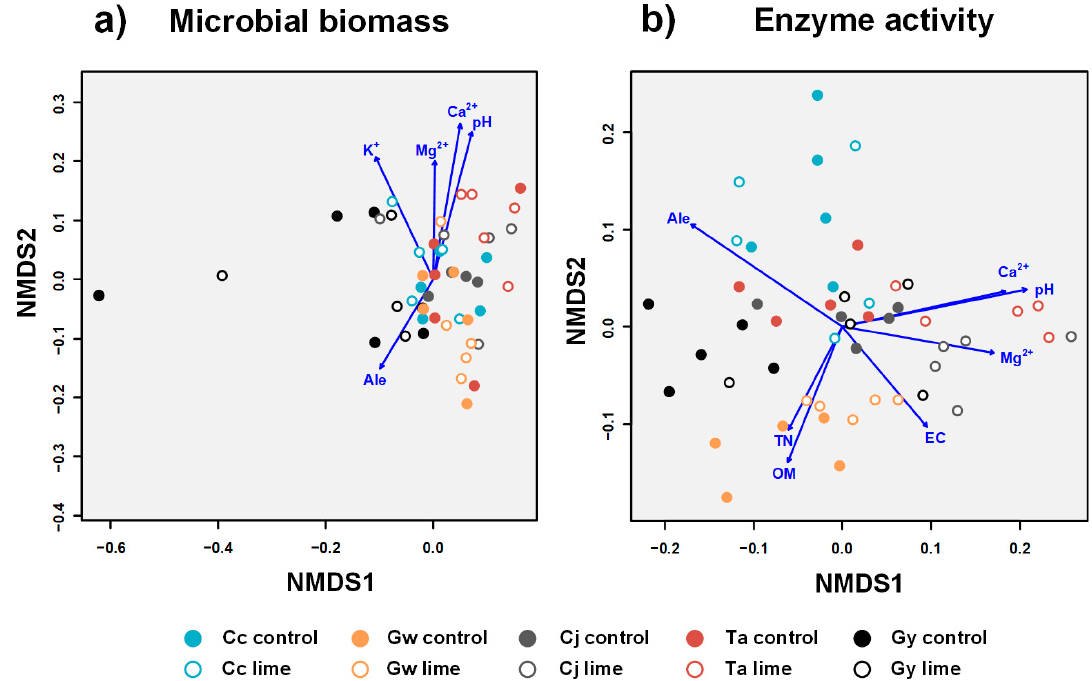
Figure 3. Nonmetric multidimensional scaling ordination between the soil chemical properties and ( a ) microbial biomass and ( b ) extracellular enzyme activities. Arrow directions indicate the correlation slopes, and arrow lengths indicate the degrees of influence of the various factors.